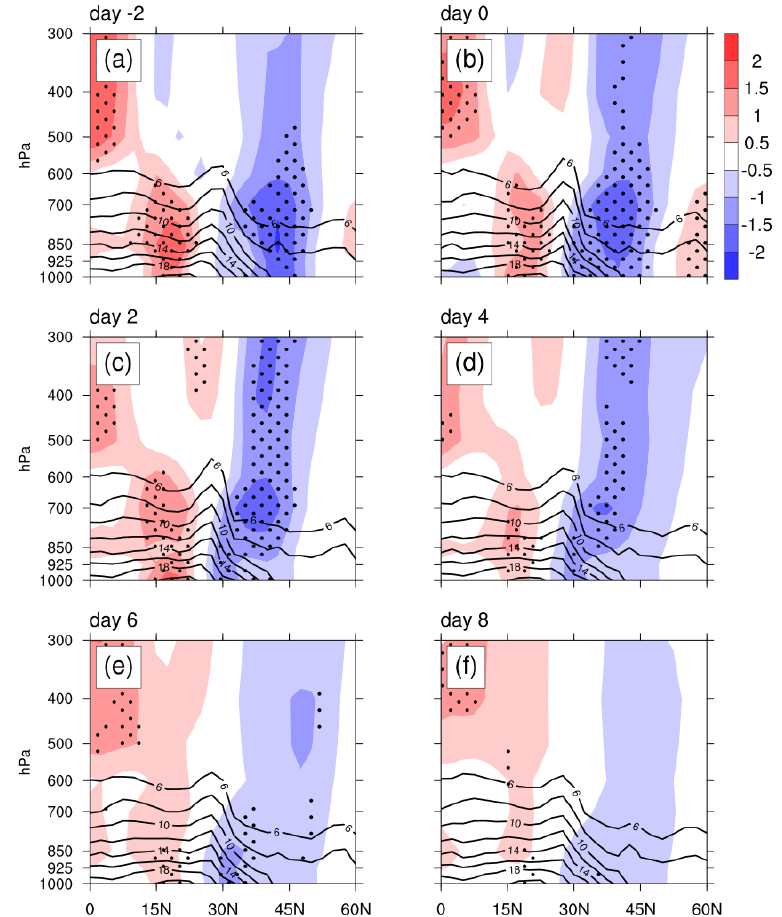
Figure 10. Latitude-pressure cross-section (115–125° E) of specific humidity (contours are from 6 to 20 g kg −1 with interval of 2 g kg −1 ) and normalized temperature anomalies (shading; every 0.5 standard deviation) in EAP/SR-C events from day −2 to day 8 with interval of 2 days ( a – f ). The dotted filled shadings denote that the normalized temperature anomalies are statistically significant at the 0.05 level.